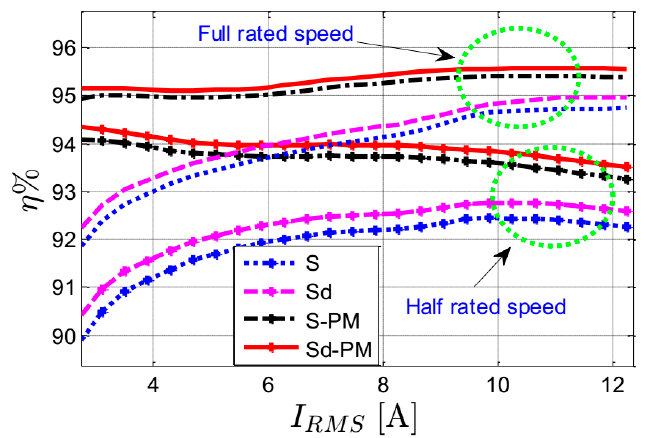
Figure 18. The simulated efficiency as a function of stator current ( RMS ) at optimal current angles (only copper and iron losses are taken into account).